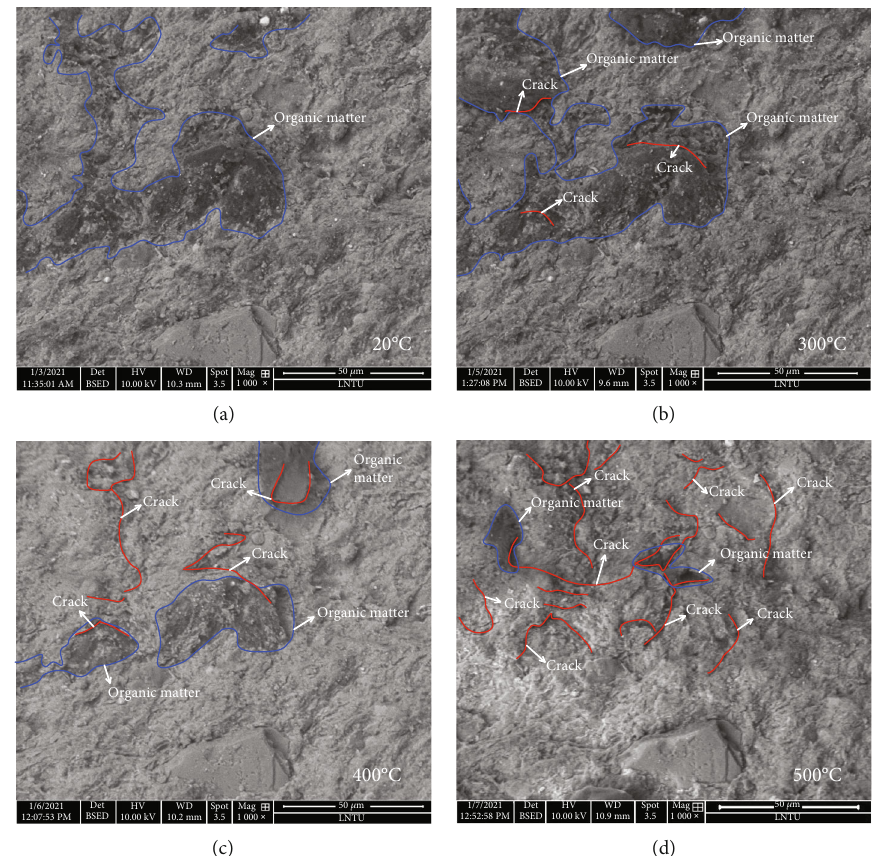
Figure 9: SEM images of oil shale before and after conduction-based heating. (a) Oil shale in the initial state. (b) Oil shale at 300 ° C. (c) Oil shale at 400 ° C. (d) Oil shale at 500 °